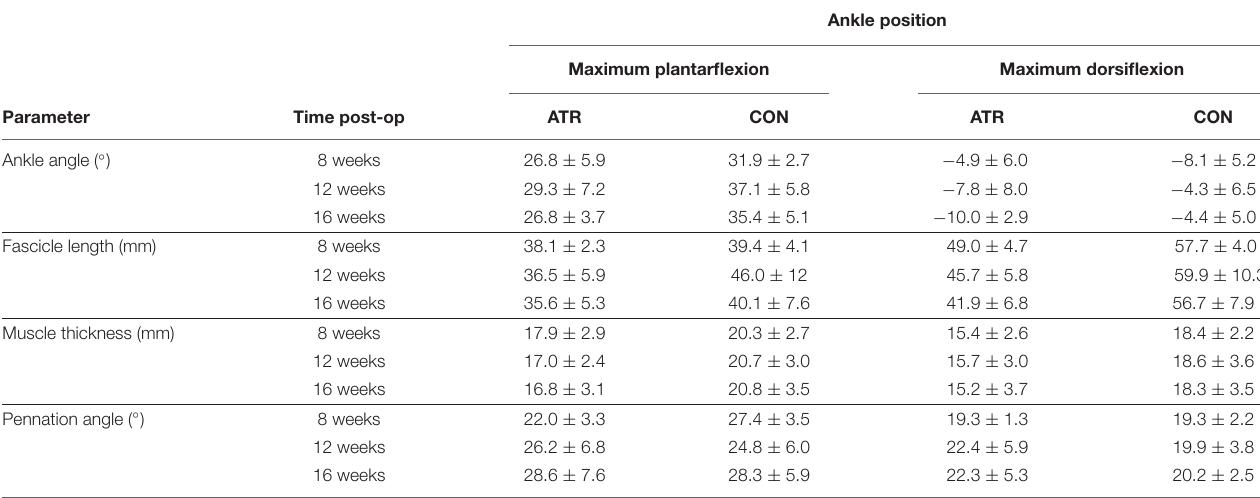
TABLE 1 | Absolute values of ankle angles and muscle architecture parameters on the ATR injured and contralateral (CON) musle-tendon units for included subjects ( n = 8) at two ankle positions at three different measurement time points during the rehabilitation period. Ankle position Maximum plantarflexion Maximum dorsiflexion